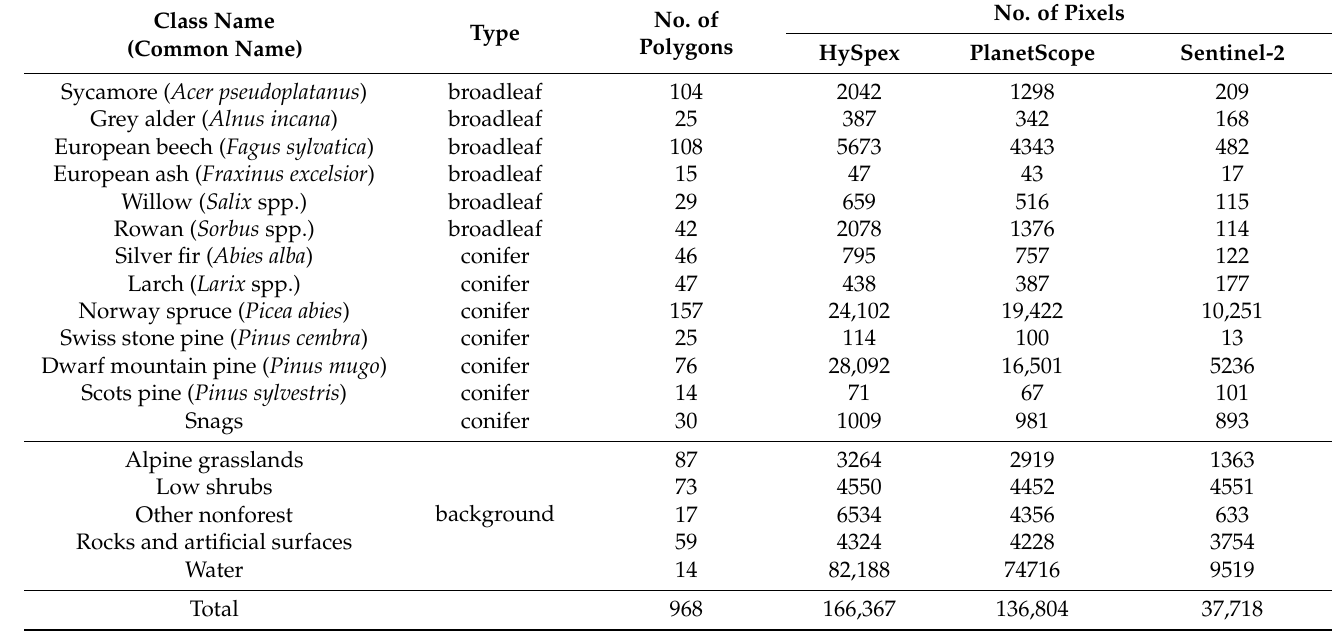
Table 1. Dominant woody species and background classes collected in situ for training and